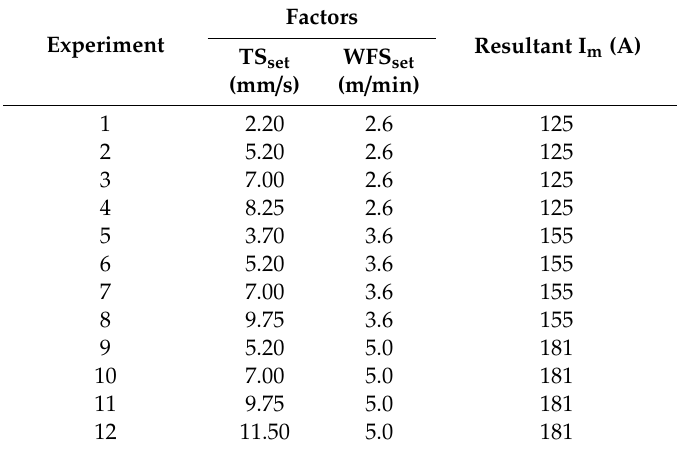
Table 6. Experimental matrix for the final design for the experiments.